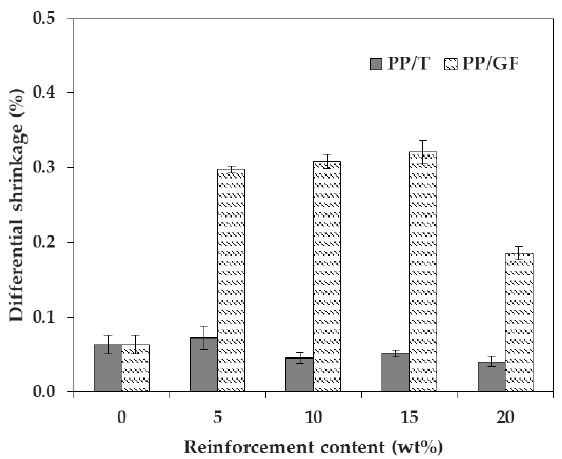
Figure 5. Differential shrinkage of PP/T and PP/GF, depending on the reinforcement type.